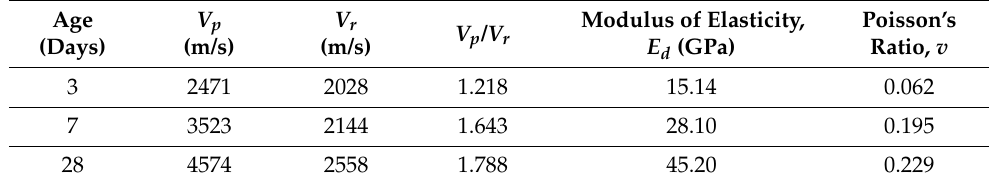
Table 9. Modulus and Poisson’s ratio for beam without fibre.